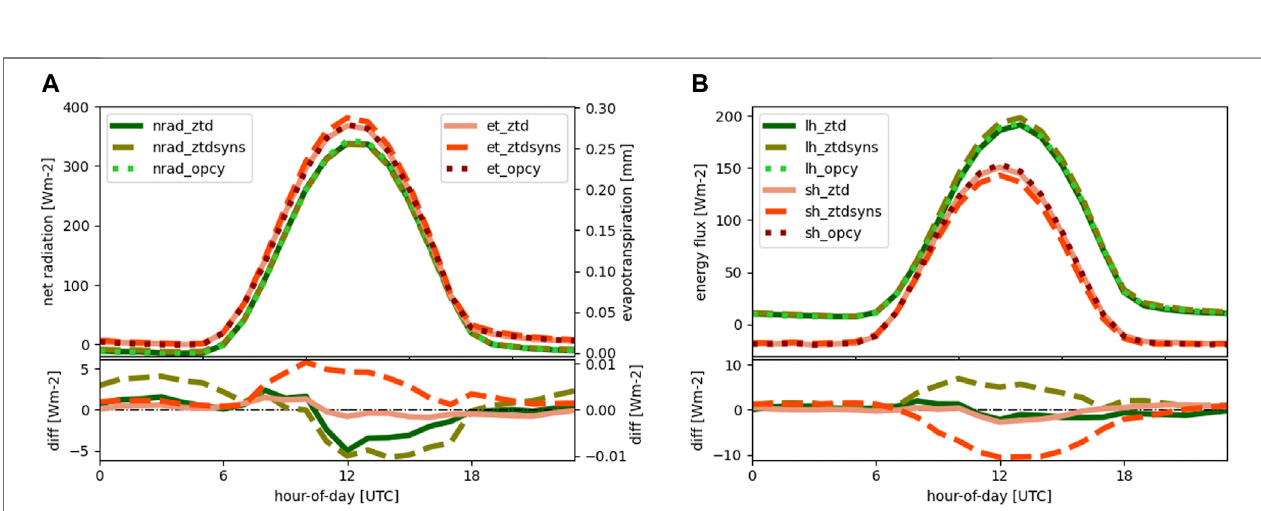
FIGURE13| Dailycycleofthedomainmeanregardingnetradiation(nrad)andevapotranspiration(et) (A) ,andsensibleheat(sh)andlatentheat fl uxes(lh) (B) forthe open cycle simulation (opcy), best assimilation setup (ztdsyn) and assimilating ZTD only (ztd) for the spring episode.